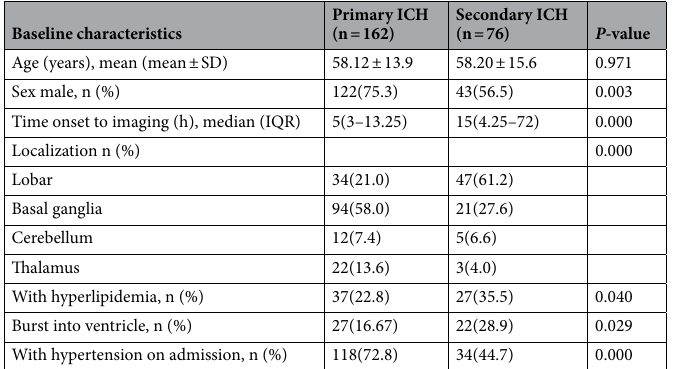
Table 1. Demographic information of the study population. Continuous variables are represented as mean ± standard deviation (SD) and categorical variables as number (n), and percentages (%). IQR=inter- quartile range; ICH=intracranial hemorrhage; HU=hounsfield unit.